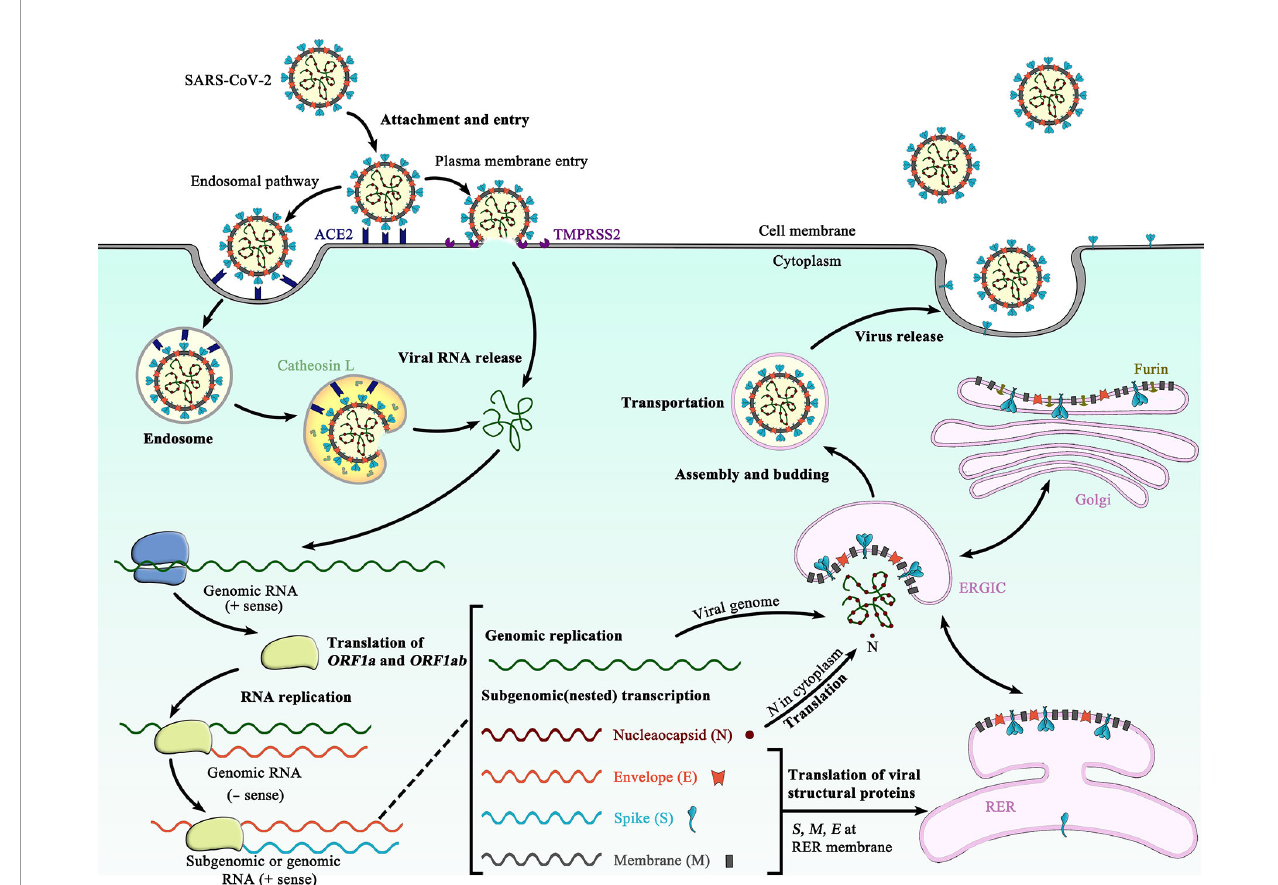
FIGURE 1 | Schematic representation of the life cycle of SARS-CoV-2. The life cycle of SARS-CoV-2 begins with membrane fusion occurring at the plasma membrane or within acidi fi ed endosomes after endocytosis, which is mediated by conformational changes in the S glycoprotein triggered by angiotensin-converting enzyme 2 (ACE2) binding. Following viral entry, SARS-CoV-2 releases its genomic RNA into the host cell cytoplasm. Genome RNA is fi rst translated into viral replicase polyproteins (pp1a and 1ab), which are further cleaved by viral proteases into a total of 16 nonstructural proteins. A replication-transcription complex (RTC) is formed based on many of these nonstructural proteins. In the process of genome replication and transcription mediated by RTC, the negative-sense ( − sense) genomic RNA is synthesized and used as a template to produce positive-sense (+ sense) genomic RNA and subgenomic RNAs. The nucleocapsid (N) structural protein and viral RNA are replicated, transcribed, and synthesized in the cytoplasm, whereas other viral structural proteins, including the S protein, membrane (M) protein and envelope (E) protein, are transcribed and then translated in the rough endoplasmic reticulum (RER) and transported to the Golgi complex. In the RER and Golgi complex, the SARS-CoV-2 glycoprotein is subjected to co-translational and post-translational processing, including signal peptide removal, trimerization, extensive glycosylation and subunit cleavage. The N protein is subsequently associated with the positive sense genomic RNA to become a nucleoprotein complex (nucleocapsid), which together with S, M, and E proteins as well as other viral proteins, is further assembled and followed by budding into the lumen of the ER-Golgi intermediate compartment (ERGIC) to form mature virions. Finally, the mature virions are released from the host cell, waiting for a new life cycle to start. This fi gure is adapted from the template in BioRender